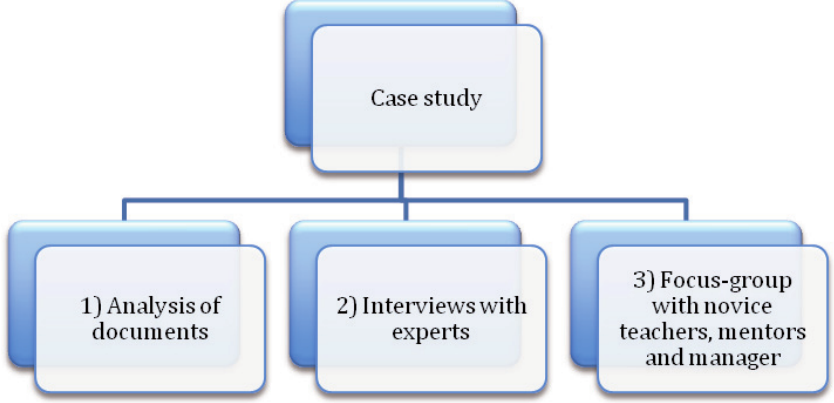
Figure 1. Stages of the case study: Implementation of the induction year for no- vice teachers in